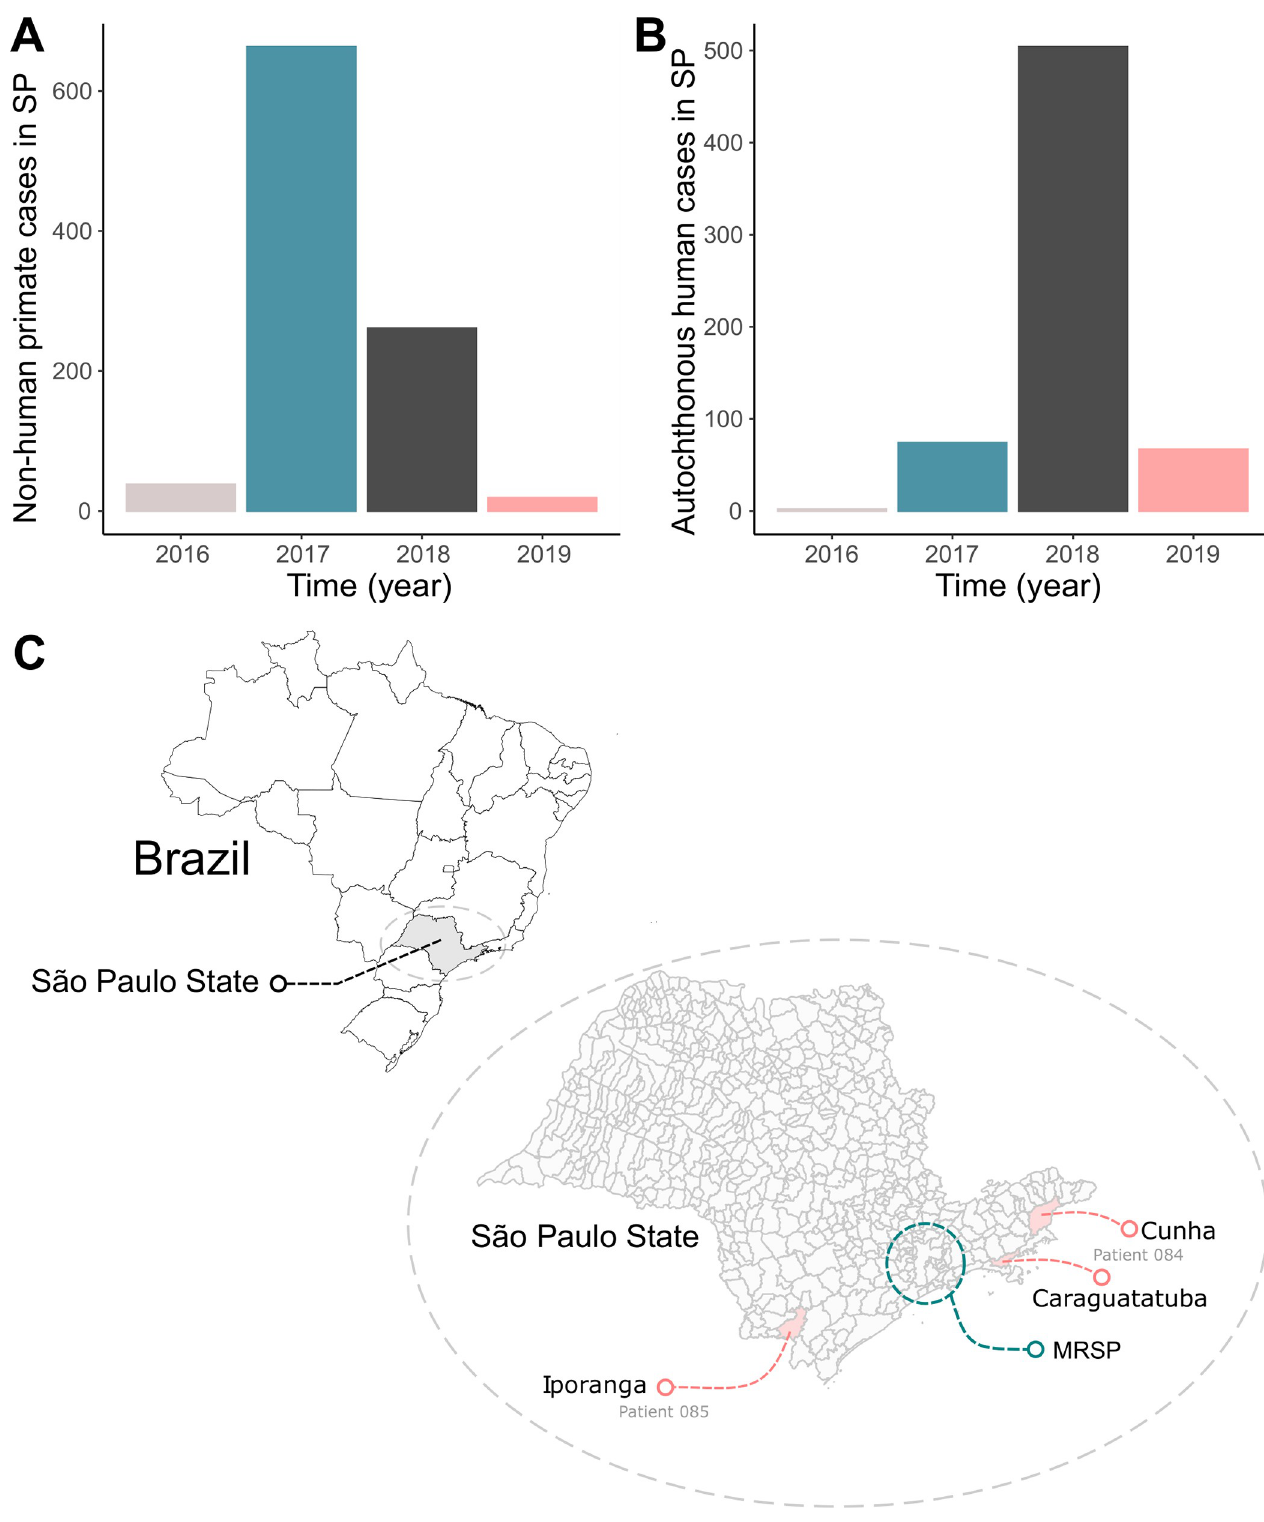
Fig 1. Epidemiological situation of the YFV outbreak in S ã o Paulo, 2016–2019. ( A ) The number of YFV positive NHPs in S ã o Paulo, from 2016–2019. ( B ) The number of YFV-positive human cases in S ã o Paulo, from 2016–2019. ( C ) Location of the two fatal human cases studied in the transition from 2018 to 2019. We used R software, geobr package, (MIT license https://ipeagit.github.io/geobr/) to create the maps produced in this Fig to visualize the spatial location.